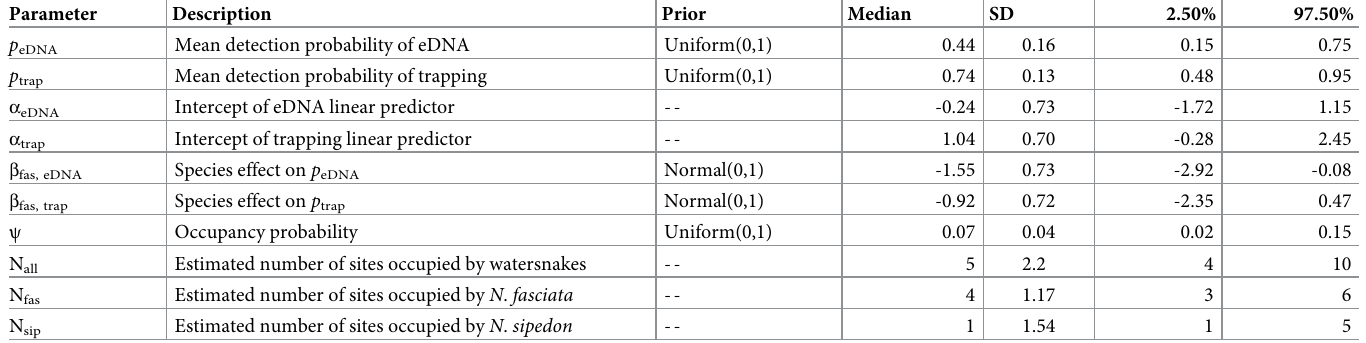
Table 3. Parameters, prior distributions, and posterior summaries for detection and occupancy parameters from a joint occupancy model that integrates both trap- ping and eDNA survey results.